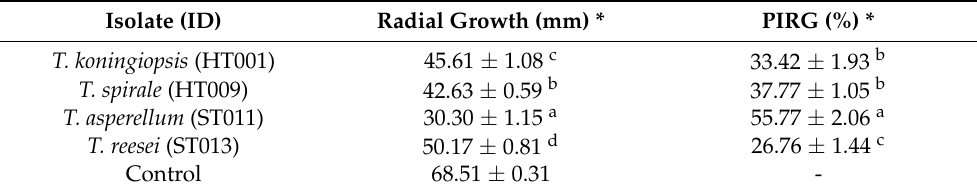
* Values are the mean of four replicates ± SD. Within each column, means with different letters are significantly different according to Tukey’s multiple comparison test ( p < 0.05).